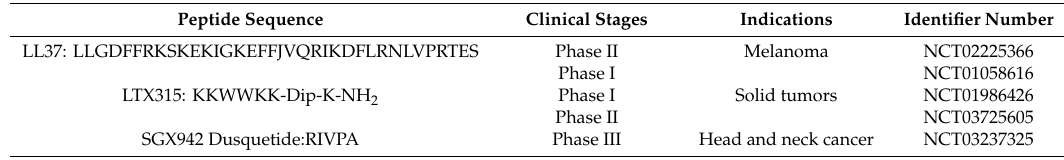
Table 2. Antimicrobial peptides under evaluation in clinical trial of cancer